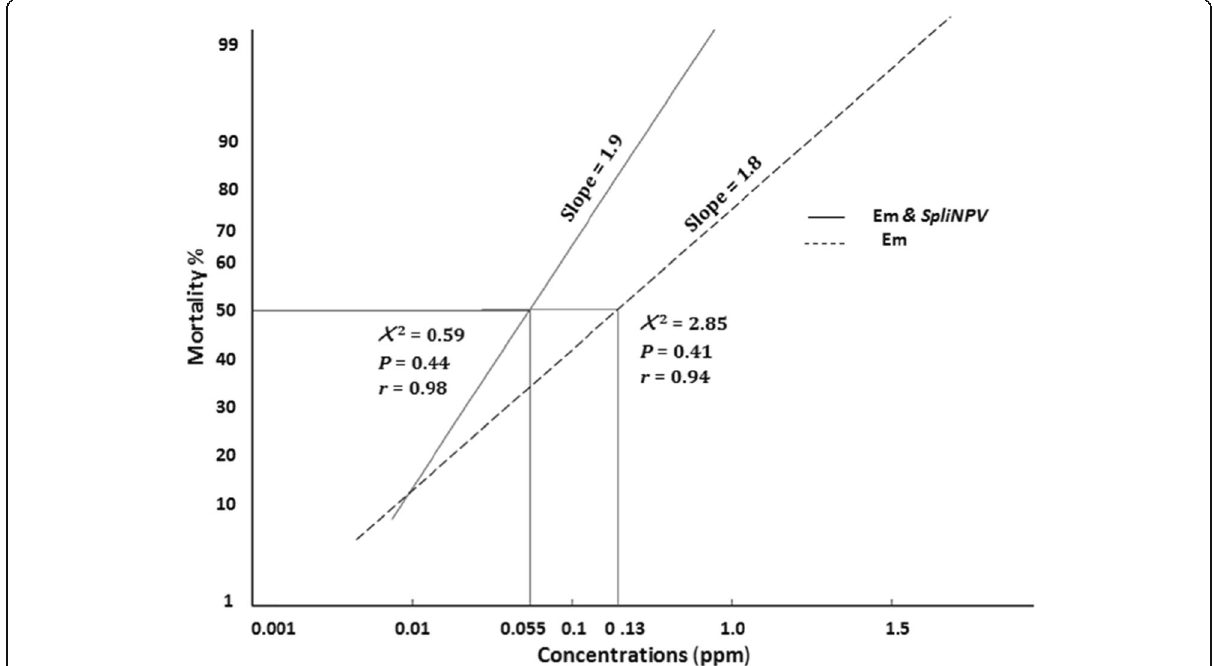
Fig. 1 % mortality of Spodoptera littoralis 2nd instar larvae treated with different concentrations of Em (ppm) and (Em concentrations ppm) + Spli MNPV 1 × 10 4 PIB/ml